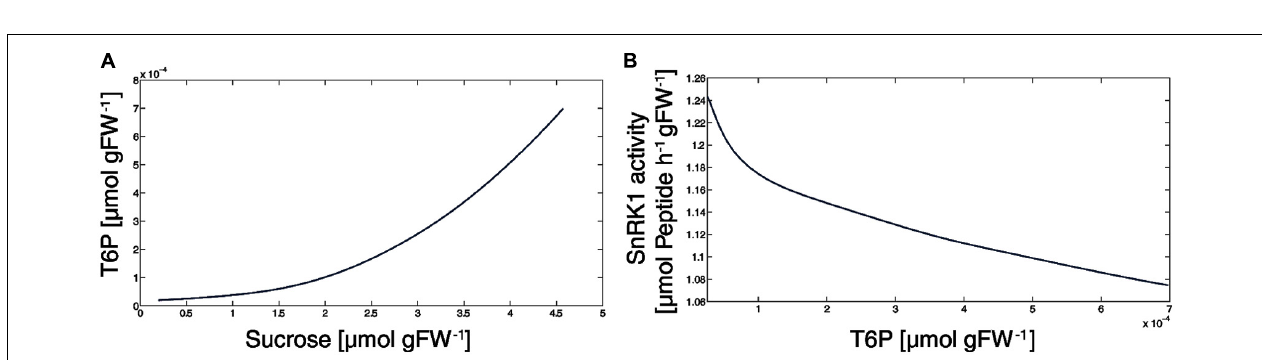
FIGURE 5 |The SnRK1-T6P-Sucrose interaction. (A) TheT6P level first increases exponentially, then linear with the sucrose level. (B) The decrease of SnRK1 activity with respect toT6P concentrations occurring during 3 h of external sucrose supply.